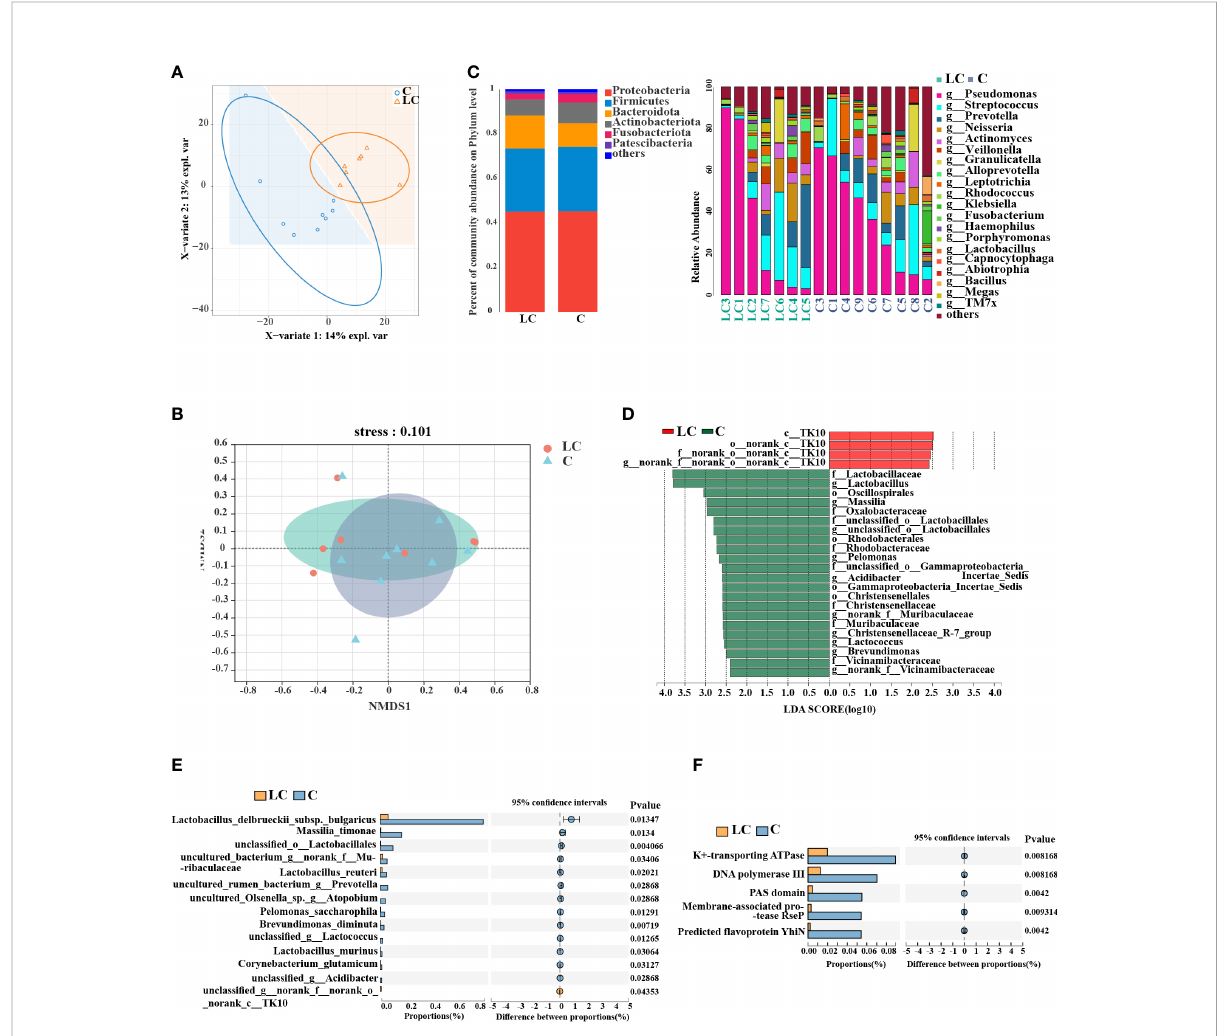
FIGURE 2 Lung microbiota composition pro fi les in LC patients and controls. (A) PLS-DA score plot of LC patients and controls showed clear distinction. (B) Non-metric multidimensional scaling analysis (NMDS) of the weighted UniFrac phylogenetic distance matrices demonstrated that the LC patients and controls showed two distinct clusters. (C) Relative abundance of major phyla and genera across BALF samples. (D) Differential taxa at the genus level identi fi ed by linear discriminant analysis (LDA) effect size (LEfSe) analysis (LDA > 2.0, P < 0.05). (E) Differential taxa at the species level identi fi ed by the Wilcoxon rank test ( P < 0.05). (F) COG functional analysis of the microbiota between LC patients and